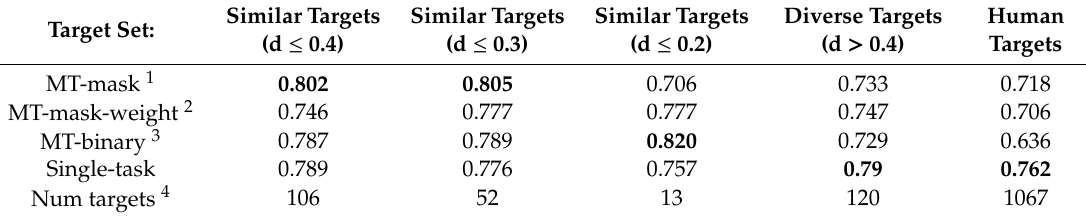
Table 3. Average target area under curve for di ff erent architectures and target